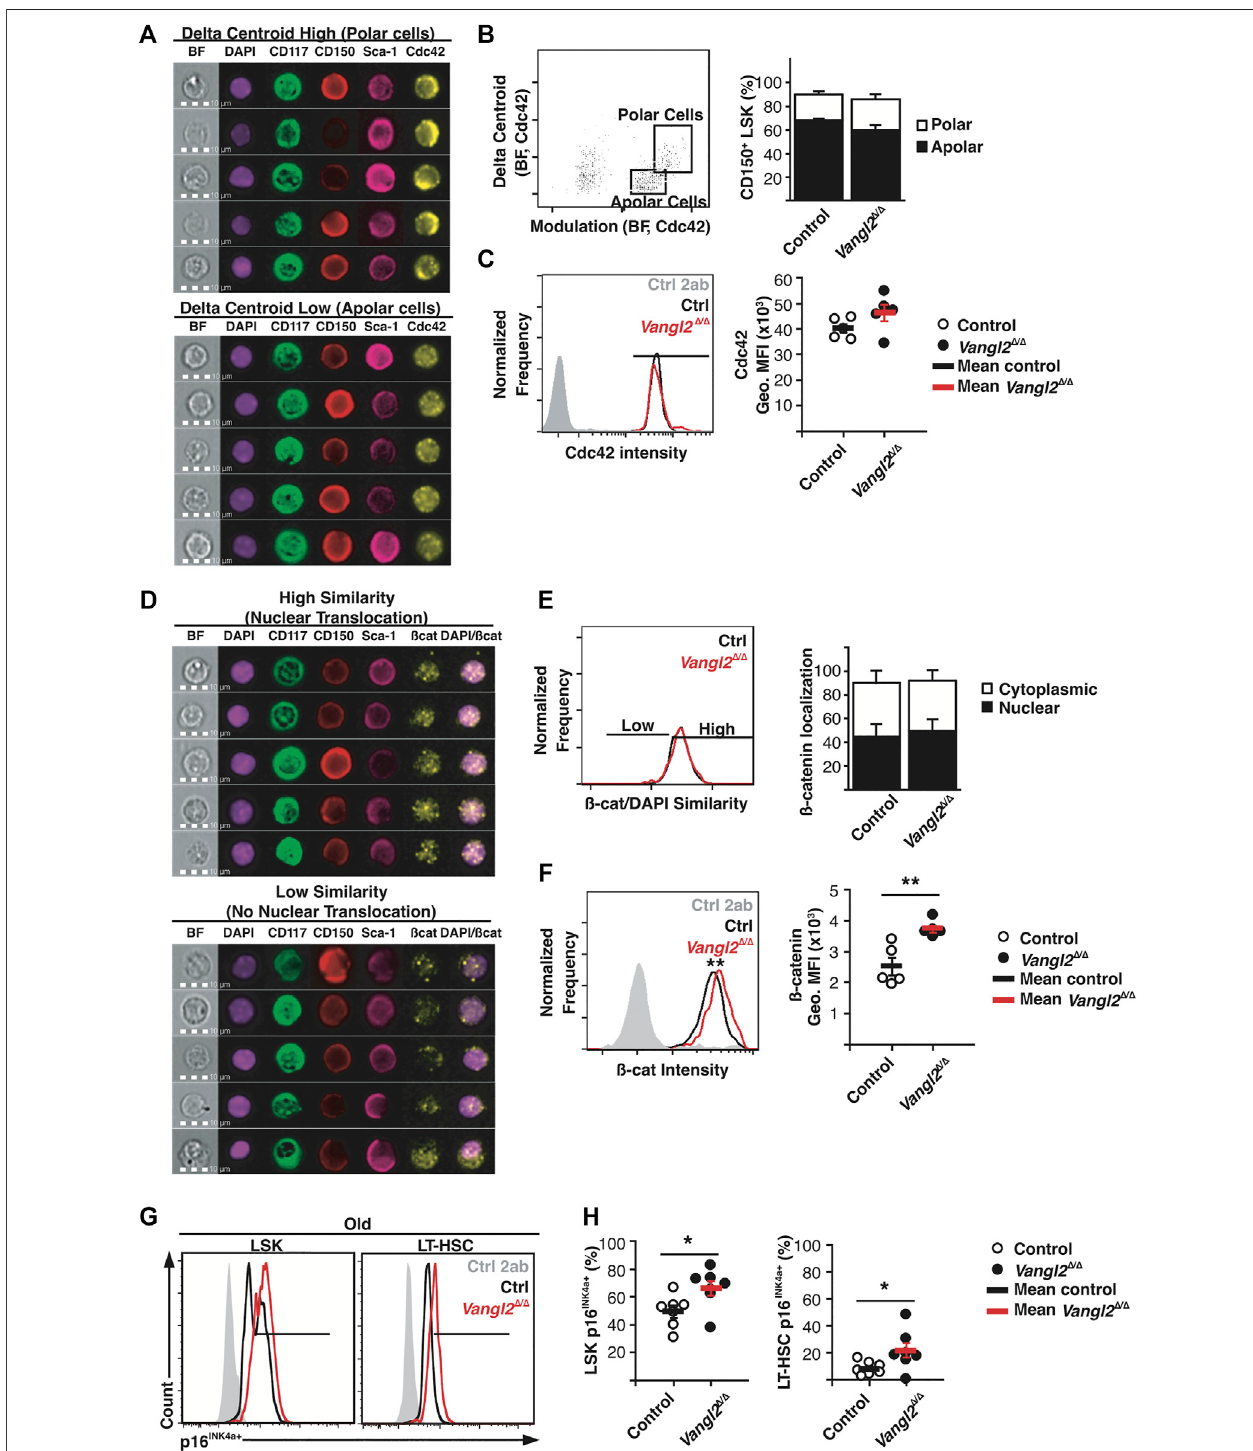
FIGURE 6 | Vangl2 loss increases β -catenin activation and p16INK4a expression in old stem/progenitor cells. (A) Representative images of polar and apolar CD150 + LSK + cells (B) Gating strategy based on Cdc42 delta centroid and morphology modulation features. Histogram represents the frequency of polar and apolar CD150 + LSK + cellsfromoldmice(mean+SEM). (C) RepresentativeoverlayofCdc42stainingintensity(left)andquanti fi cationofCdc42geometricmeanof fl uorescence intensity (Geo. MFI). (D) Representative images of β -catenin ( β -cat) nuclear translocation based on β -catenin/DAPI similarity analysis. (E) Gating strategy based on β -cat/DAPI similarity dilate analysis. Histogram represents cytoplasmic and nuclear β -catenin localization in old CD150 + LSK + cells (mean +SEM). (F) Representative